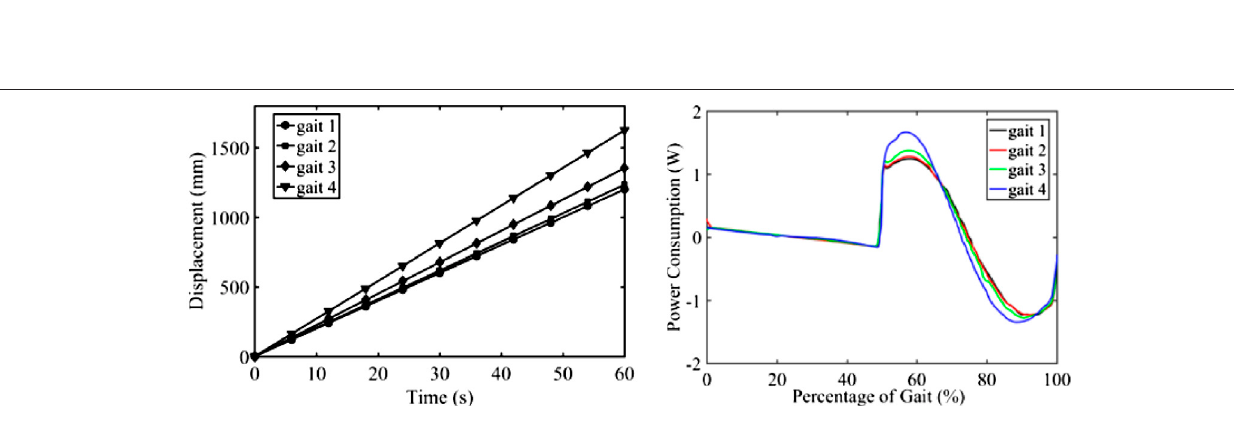
FIGURE 11 | Snapshots of simulations with different con fi guration (A . gait 1, B . gait 4).